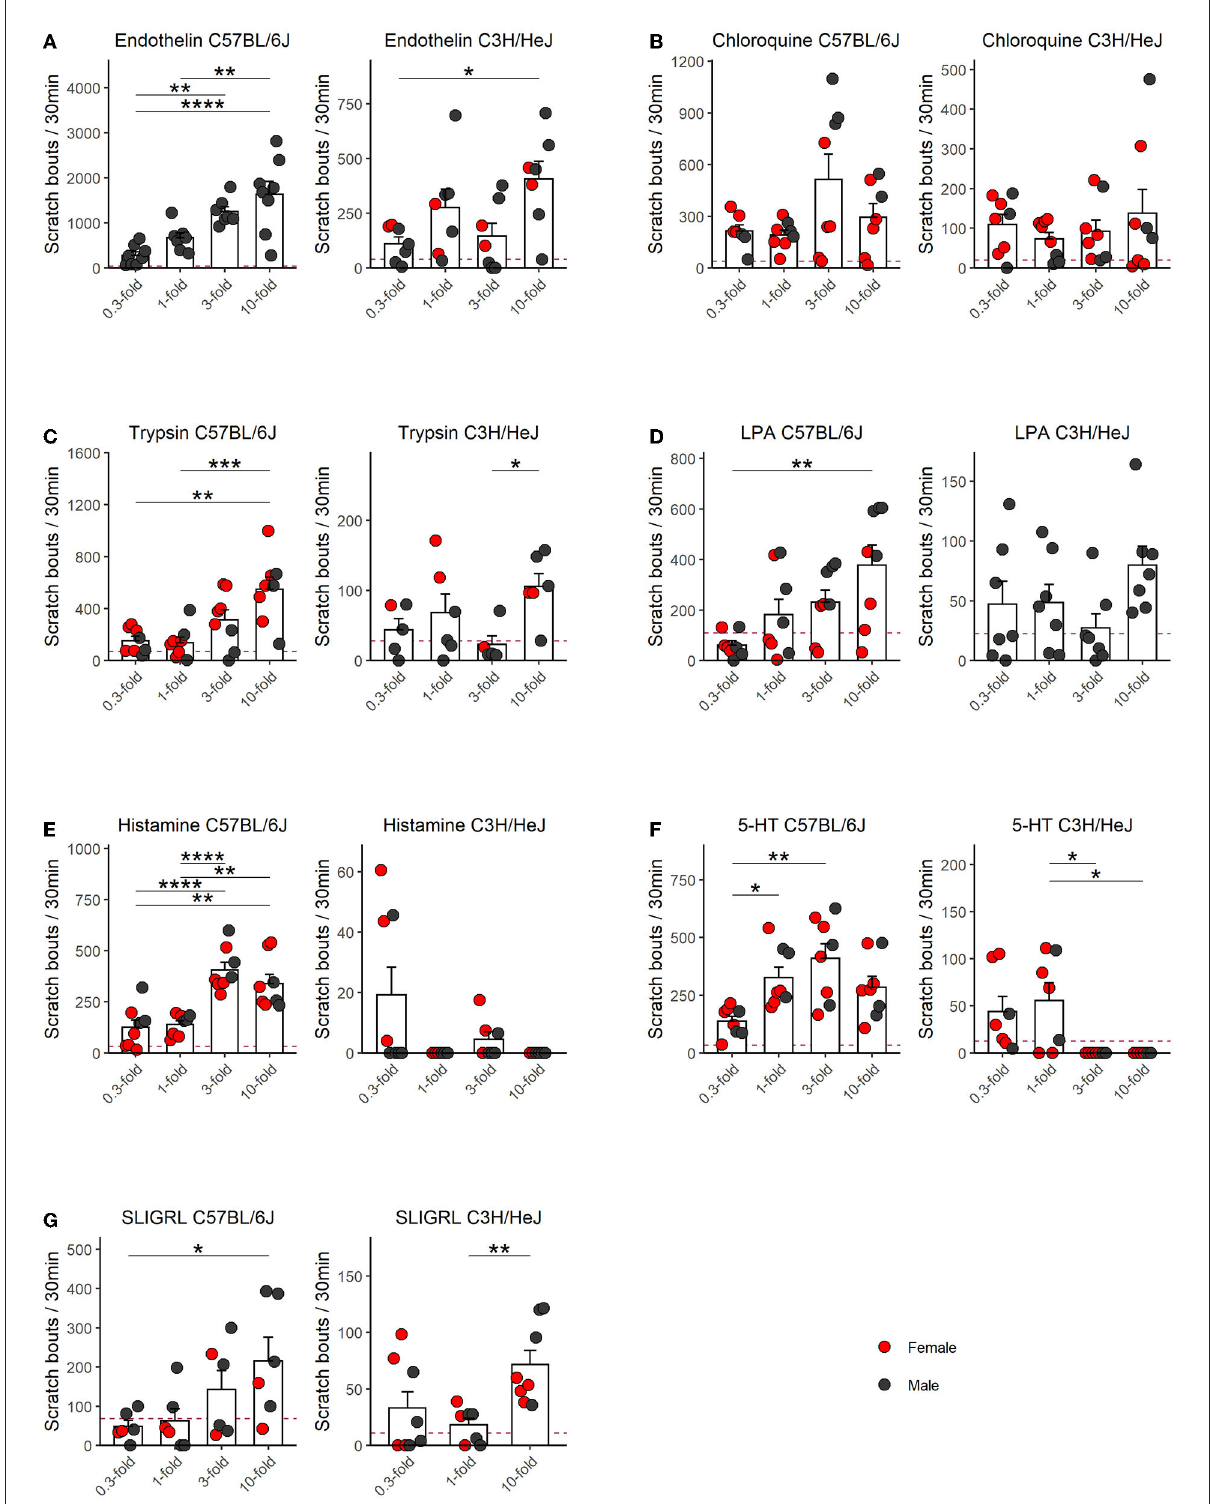
FIGURE2 Dose–response relationships of scratching behavior in C57 and C3H mice for seven pruritogens. Columns represent means ± SEM of scratch bouts in 30min following an injection of, (A) endothelin (0.3–10 µ M; C57 n = 8 males; C3H n = 7, two females, five males), (B) chloroquine (1.2–40mM; C57 n = 6, four females, two males; C3H n = 8, three females, five males), (C) trypsin (3.03–101 U/ µ l; C57 n = 8, five females, three males; C3H n = 6, two females, four males), (D) LPA (1.2–40mM; C57 n = 8, four females, four males; C3H n = 7, seven males), (E)